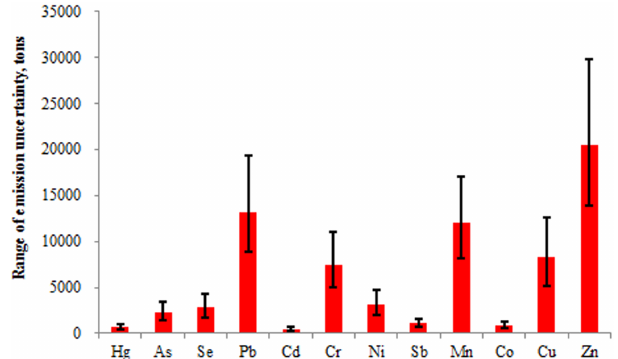
Figure 6. Uncertainties in the total emissions of HMs in China in 2010 (uncertainties in the emissions of HMs by source categories in China in 2010 can be seen in the Supplement, Table